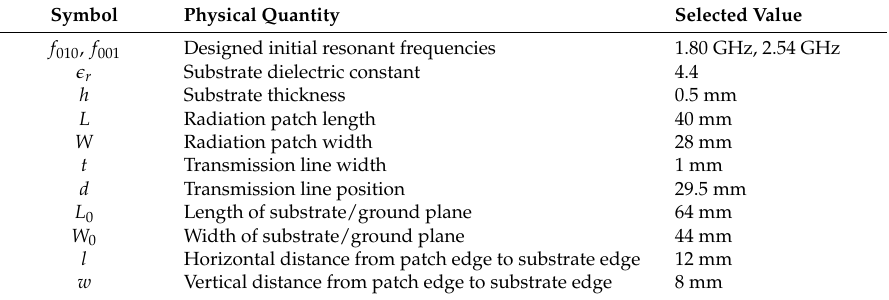
Figure 3. Antenna sensor design parameters. Table 1. Detailed parameters of the designed antenna sensor.